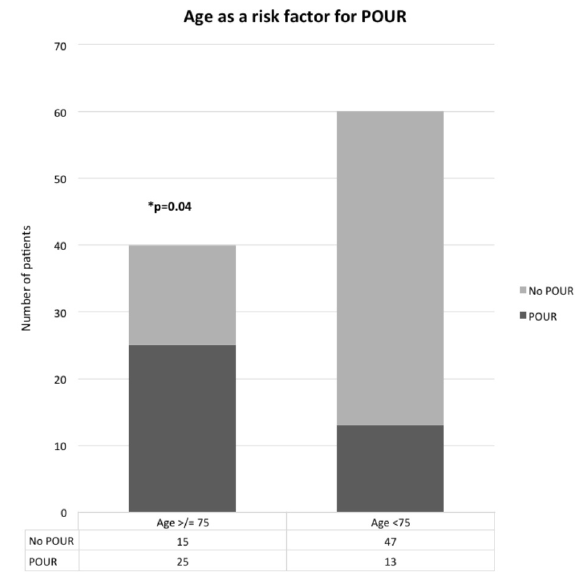
POUR following lower limb arthroplasty is significantly Fig. 2: associated with increasing age.